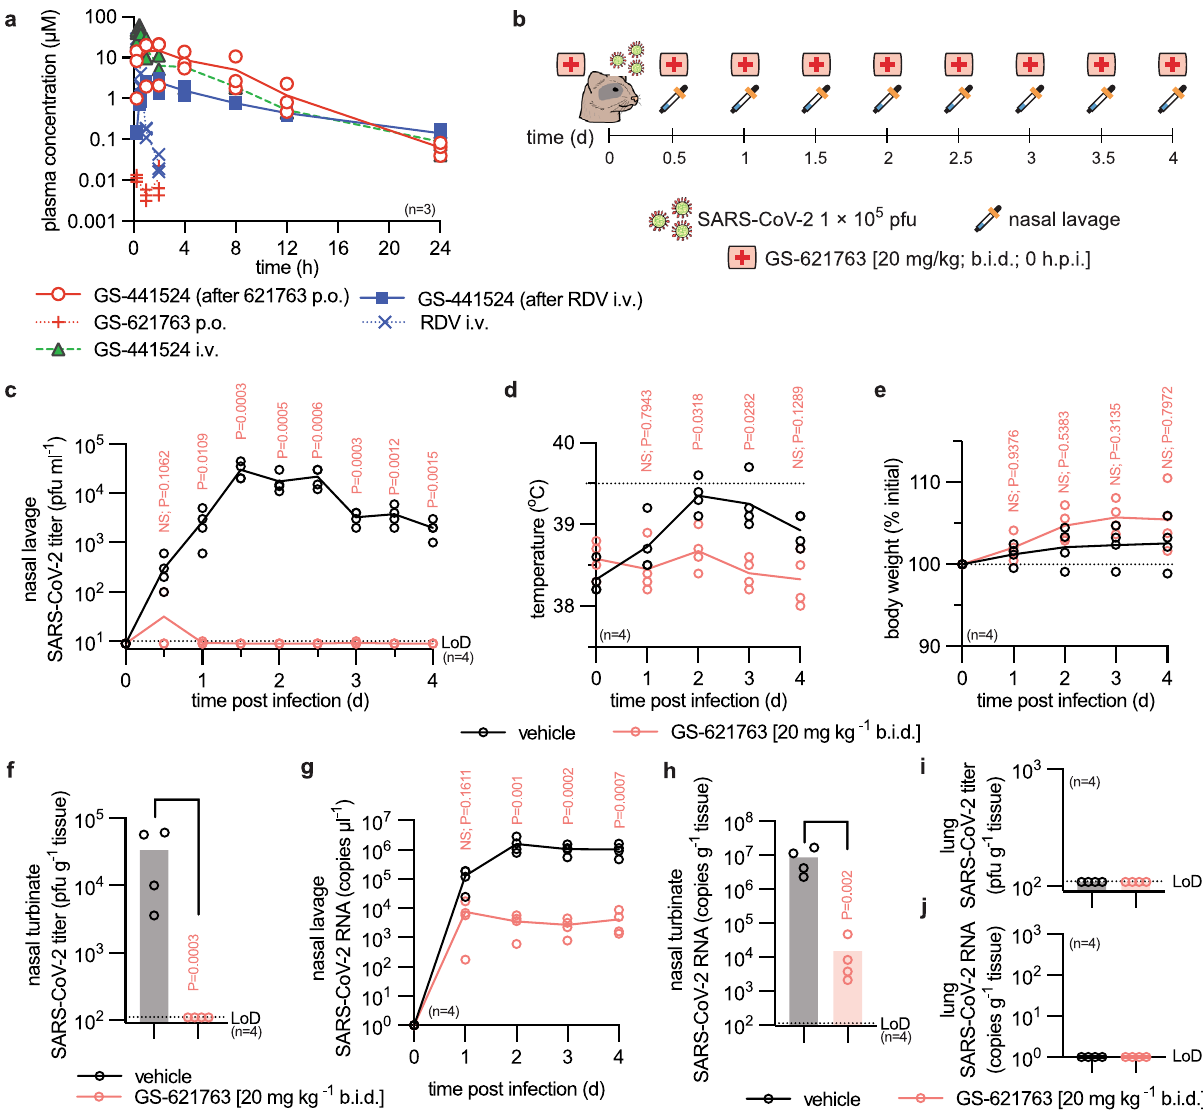
Fig. 2 Prophylactic ef fi cacy of GS-621763. a Single-dose PK study in ferrets showing plasma concentrations of GS-441524, GS-621763, and remdesivir (RDV) as speci fi ed after dosing with GS-621763 (30mg/kg; p.o.; red “ + ” symbols), remdesivir (10mg/kg; i.v.; blue “ × ” symbols), and GS-441524 (20mg/kg; i.v.; green triangles). Symbols represent individual biological repeats ( n = 3), lines depict sample means. b , Schematic of the prophylactic ef fi cacy study